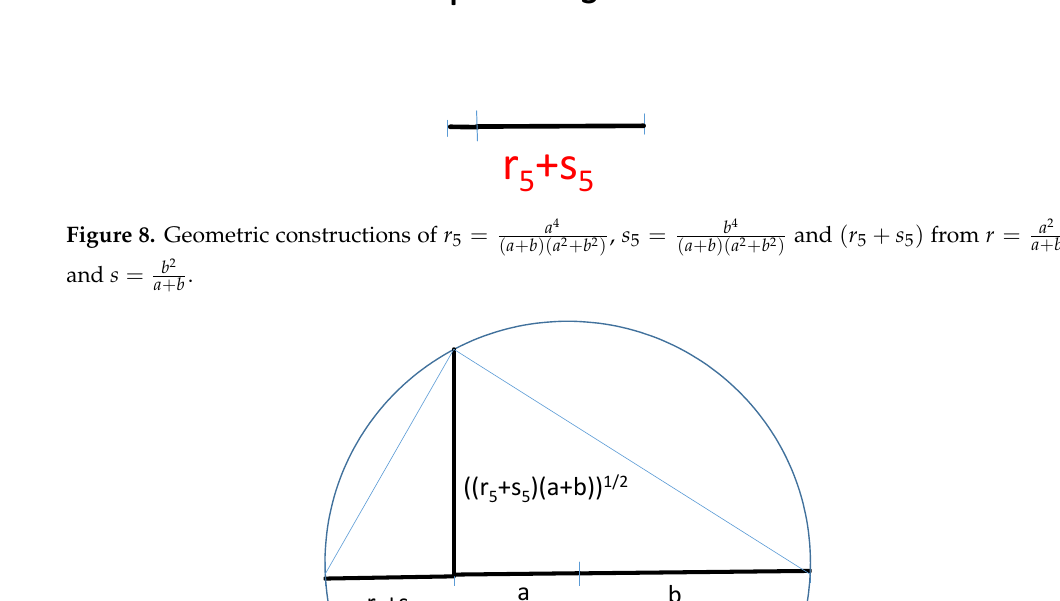
(cid:112) ( r 5 + r 6 )( a + b )